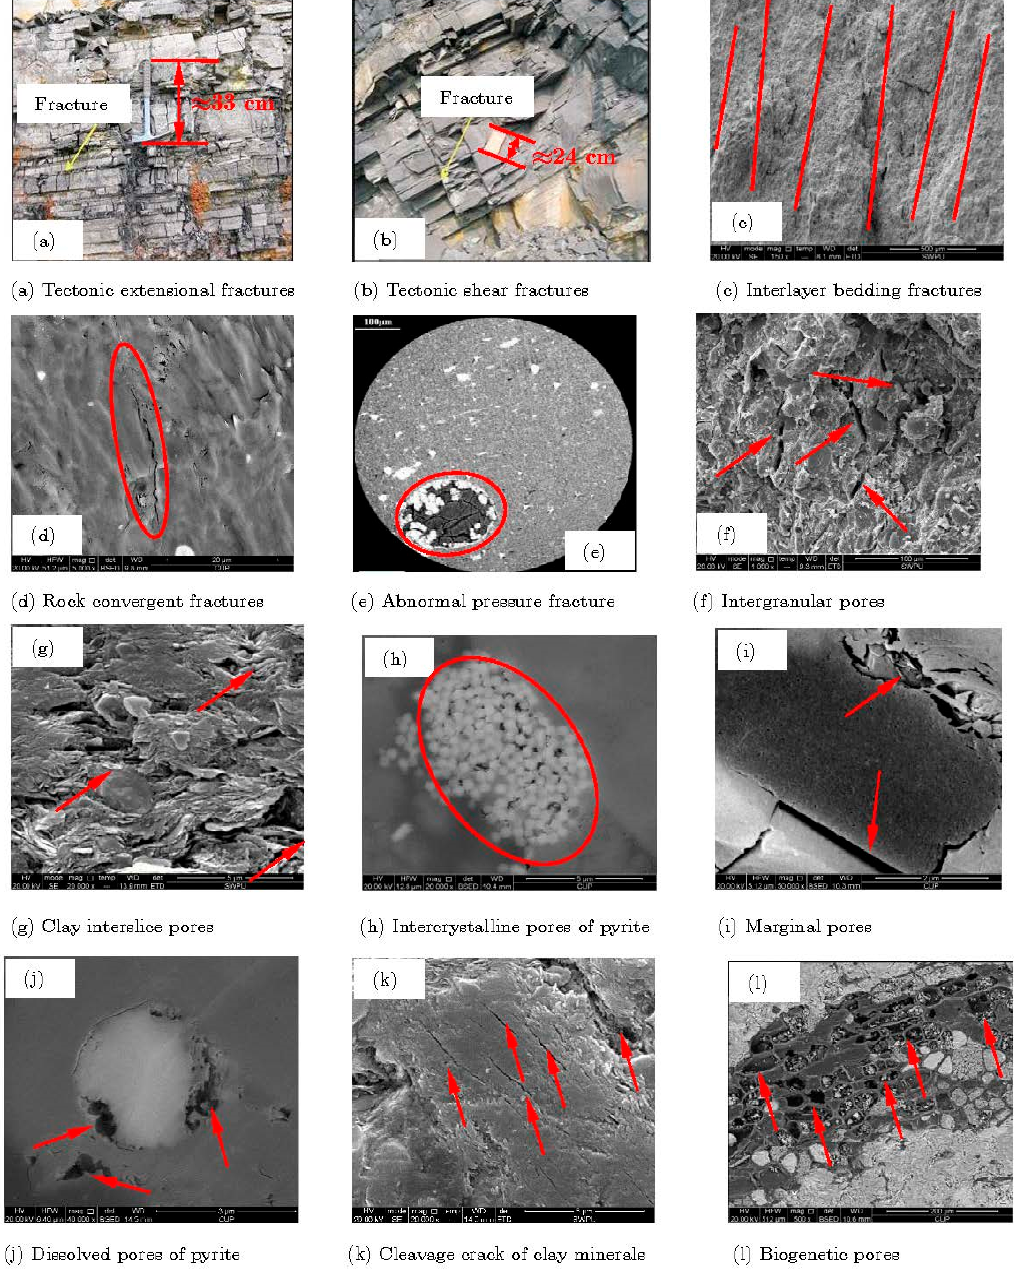
Figure 8. Different types of pores or fractures in the Longmaxi Shale Formation. ( a ) Tectonic extensional fractures. ( b ) Tectonic shear fractures. ( c ) Interlayer bedding fractures. ( d ) Rock convergent fractures. ( e ) Abnormal pressure fracture. ( f ) Intergranular pores. ( g ) Clay interslice pores. ( h ) Intercrystalline pores of pyrite. ( i ) Marginal pores. ( j ) Dissolved pores of pyrite. ( k ) Cleavage crack of clay minerals. ( l ) Biogenetic pores.